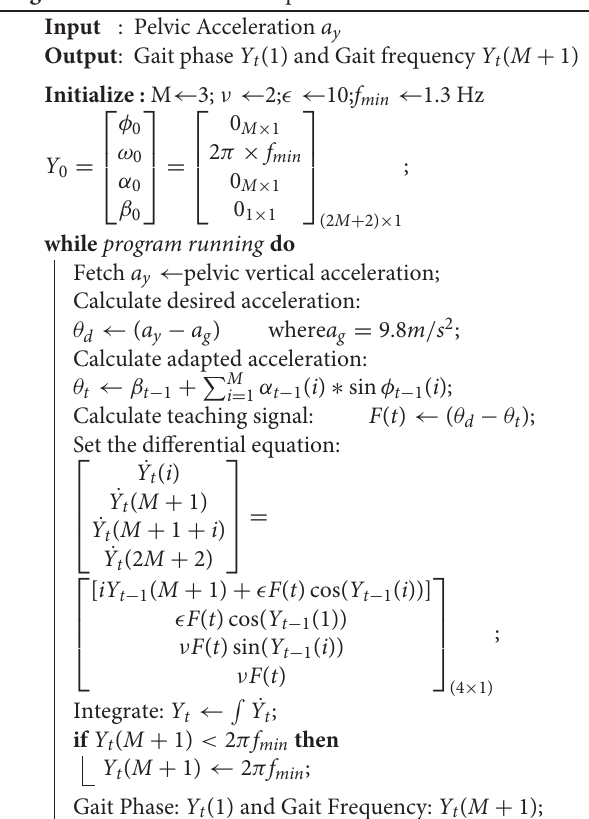
Algorithm 1: Gait Phase Adaptation